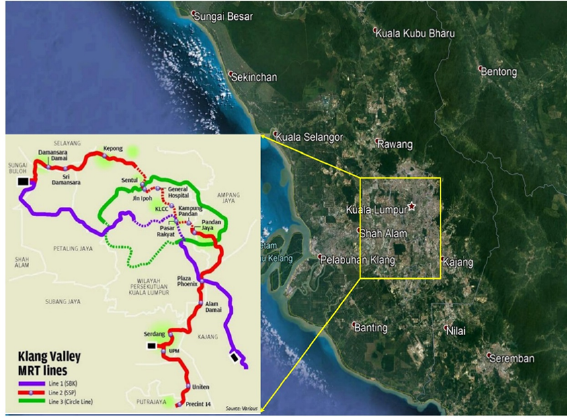
Fig. 1. Location of the KVMRT project